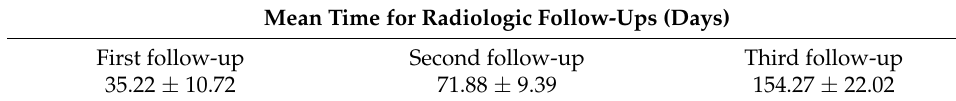
Table 1. Mean time for radiologic follow-ups (days).